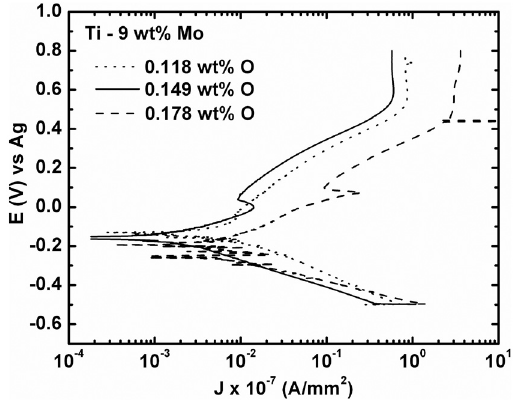
Figure 5. Potentiodynamic anodic polarization diagram of Ti-9Mo samples, with three different oxygen